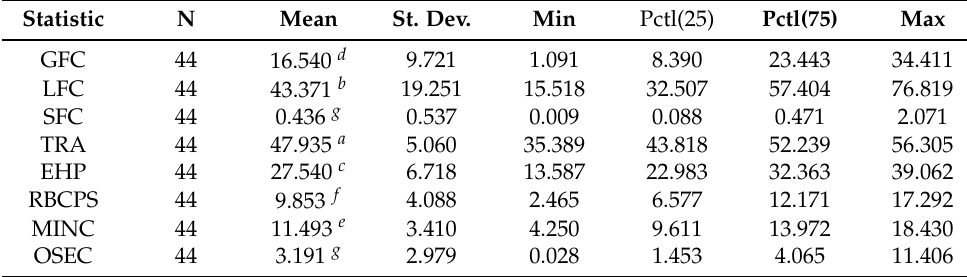
Table 2. Descriptive statistics of the disaggregated emissions